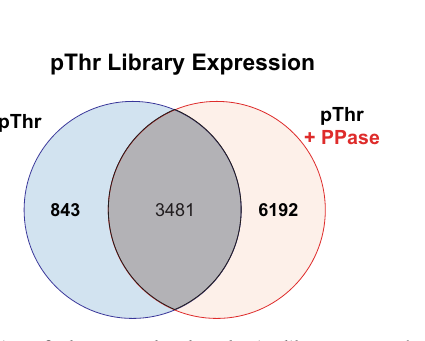
phosphosites identi fi ed between all pThr and Thr datasets. Data were combined fromtwobiologicalreplicatesforeachlibrarytypewithThrdataencompassingsix high pH reversed-phase fractions each and the pThr data as in part